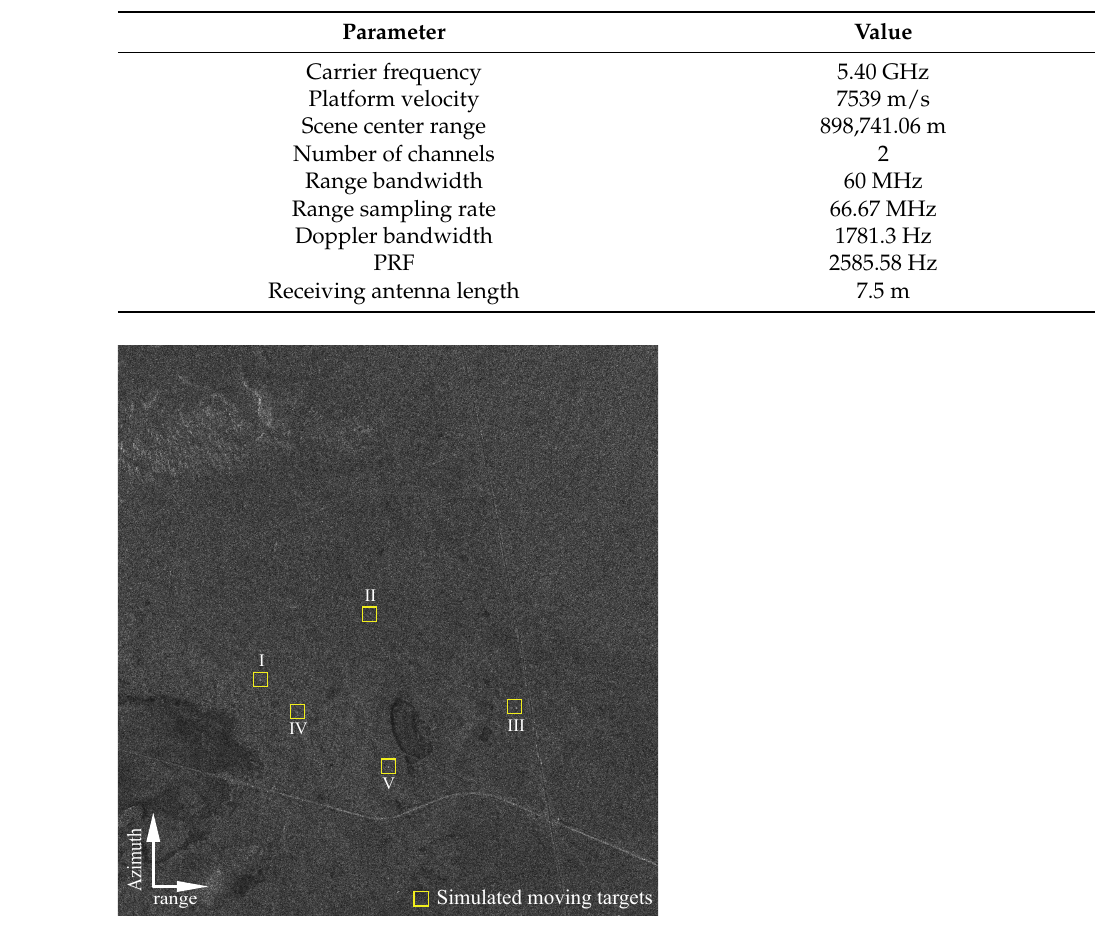
Figure 10. The stationary scene, which contains five simulated targets moving along with the three roads. Table 4. Velocities of the simulated moving